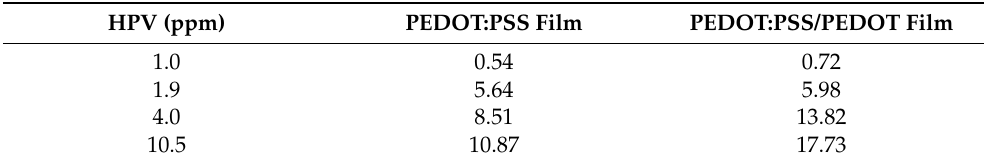
Table 1. Comparison of resistance response ( ∆ R/R 0 ) of PEDOT:PSS and PEDOT:PSS/PEDOT films under different concentrations of HPV. HPV (ppm) PEDOT:PSS Film PEDOT:PSS/PEDOT